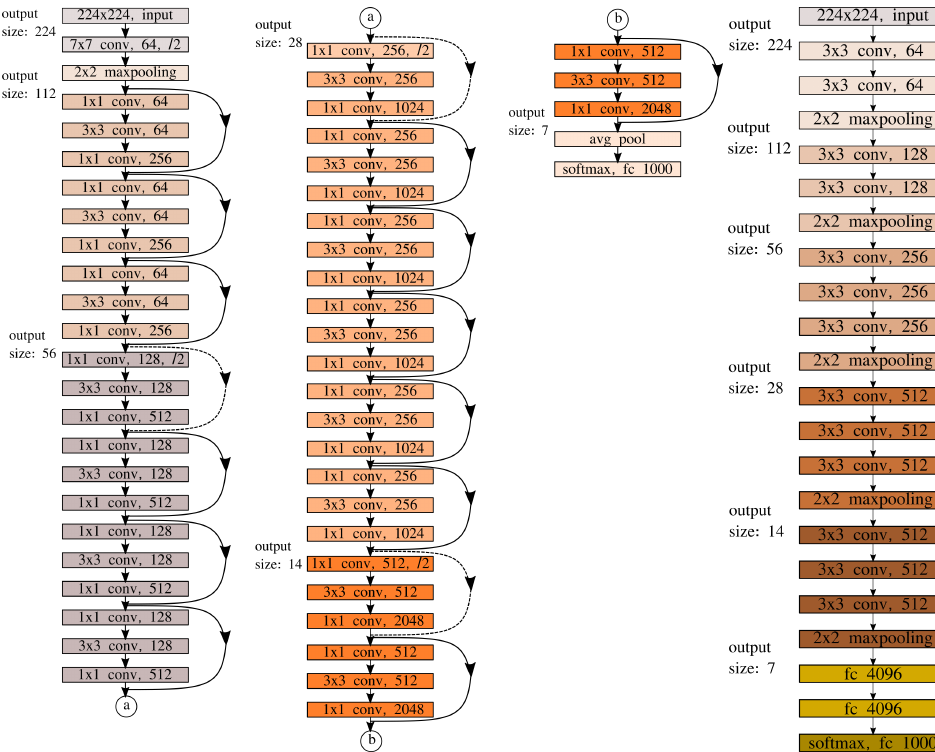
Figure 4. ResNet structures with 50 layers ( left ), adapted from [35]; VGG-16 architecture ( right